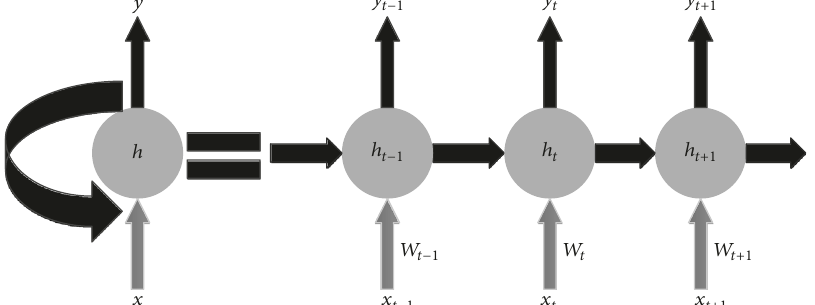
Figure 3: Architecture of the Recurrent Neural Networks and unfolding Recurrent Neural Networks into a full network. 𝑥 𝑡 is the input at time step 𝑡 . ℎ 𝑡 is the hidden state at time step 𝑡 , which is the “memory” of the network. 𝑦 𝑡 is the output at time step 𝑡 .